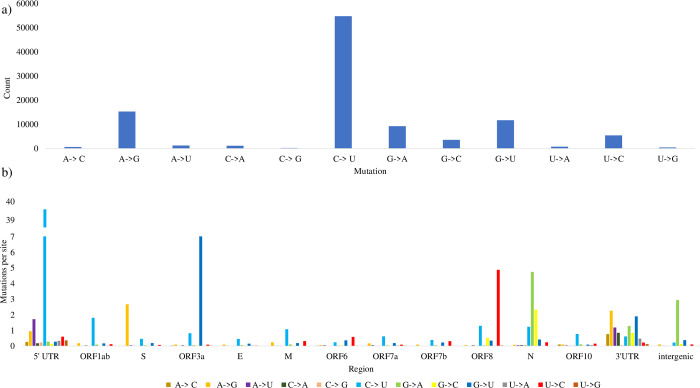
SNPs in 28474 SARS-CoV-2 (complete and incomplete) strains (samples collected up to 5-6-2020), with reference to strain Wuhan-Hu-1 (MN908947, 12-31-2019).Panel a) shows the frequency of each type of mutation in all isolates relative to the reference strain. Panel b) indicates the number of region-specific mutations normalized by region length (Mutations per site = count/sequence length) across all 13 viral regions and at the intergenic spaces. Indels and ambiguous point mutations were omitted from the analysis.